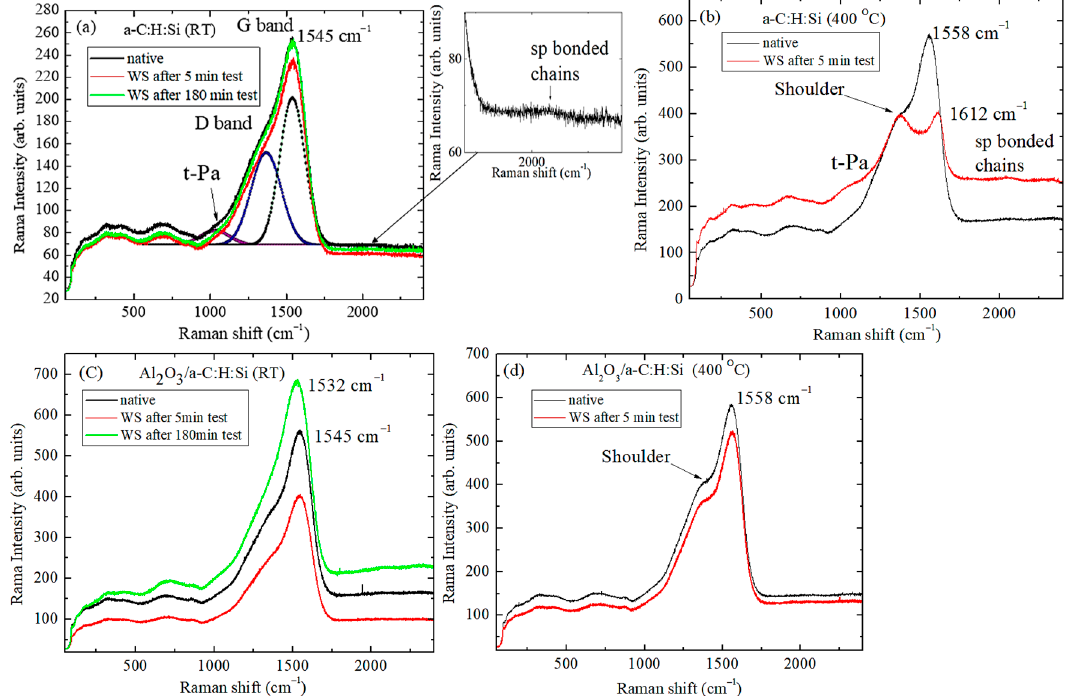
Figure 7. Raman spectra taken on the native surface and within the wear scars after the 5 and 180 min tests at RT and 400 °C on the ( a , b ) a-C:H:Si and ( c , d ) Al 2 O 3 /a-C:H:Si coatings. The insert shows the peak 1900–2200 cm − 1 corresponding to sp-bonded chains. Deconvolution of Raman spectra of the native a-C:H:Si is shown.